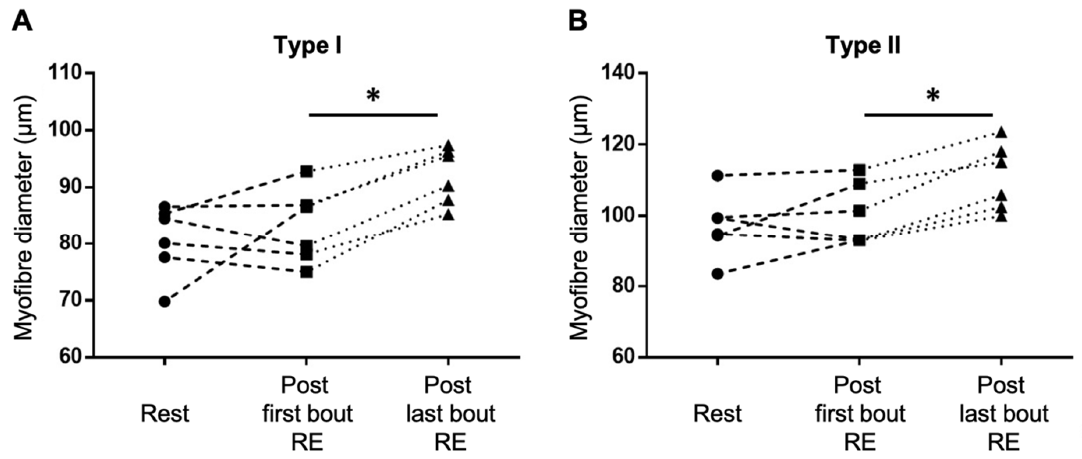
Figure 2. Five weeks of resistance training induced a skeletal muscle fibre hypertrophy of both type I ( A ) and type II ( B ) muscle fibres. * p < 0.05.